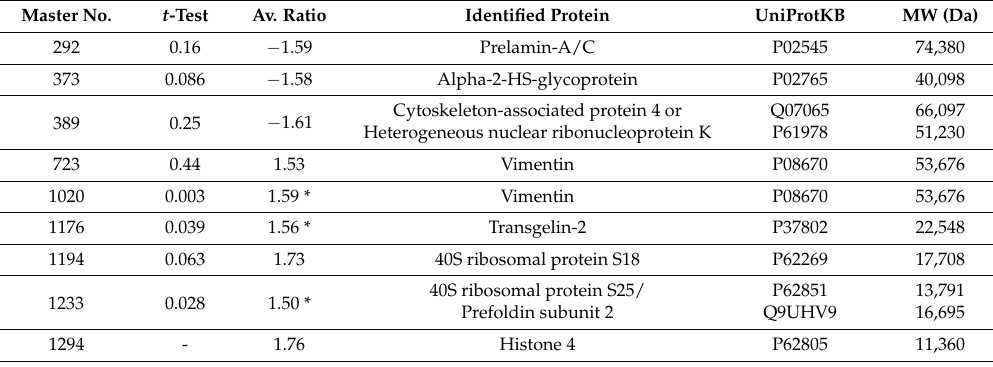
Table 1. Differentially expressed proteins in CXCL-8 treated, pre-inflamed HMVECs. Master No.